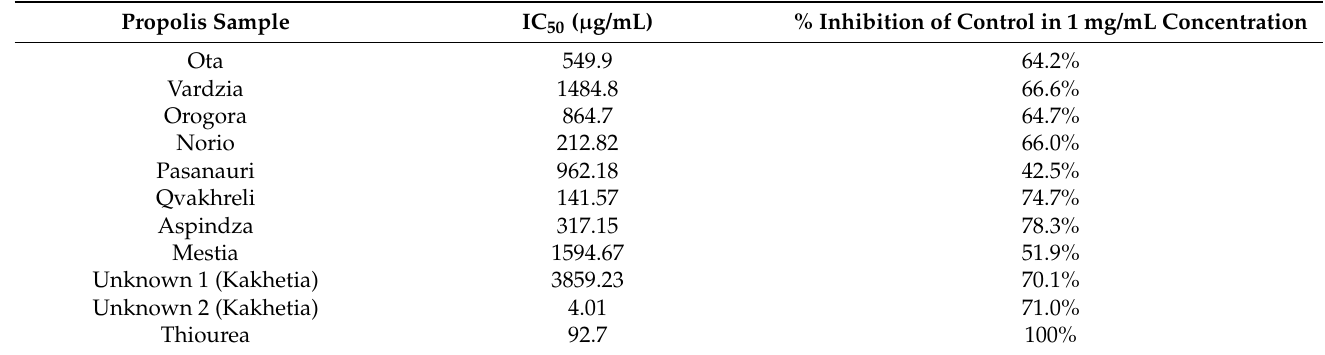
Table 2. Antibacterial activity (MIC) and inhibition of H. pylori urease (IC 50 ) by tested Georgian propolis